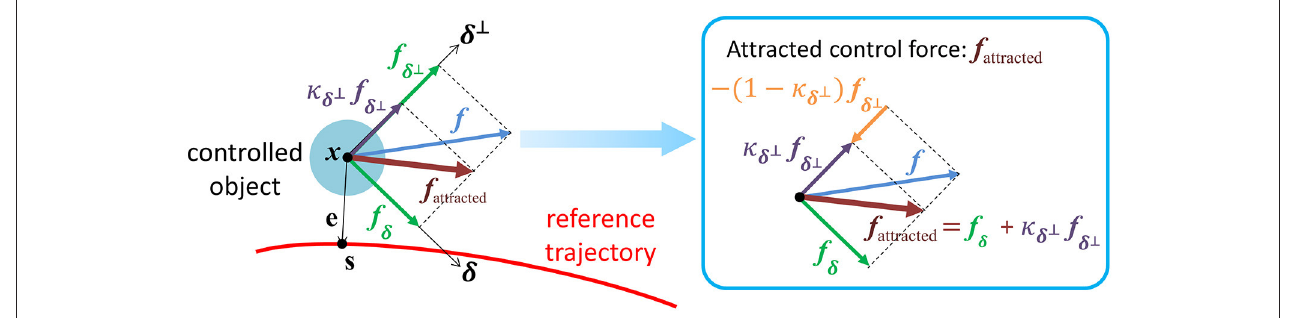
FIGURE 7 | A graphical illustration of the attracted control force f attracted . The intensity of guidance is determined by 1 − κ δ ⊥ .